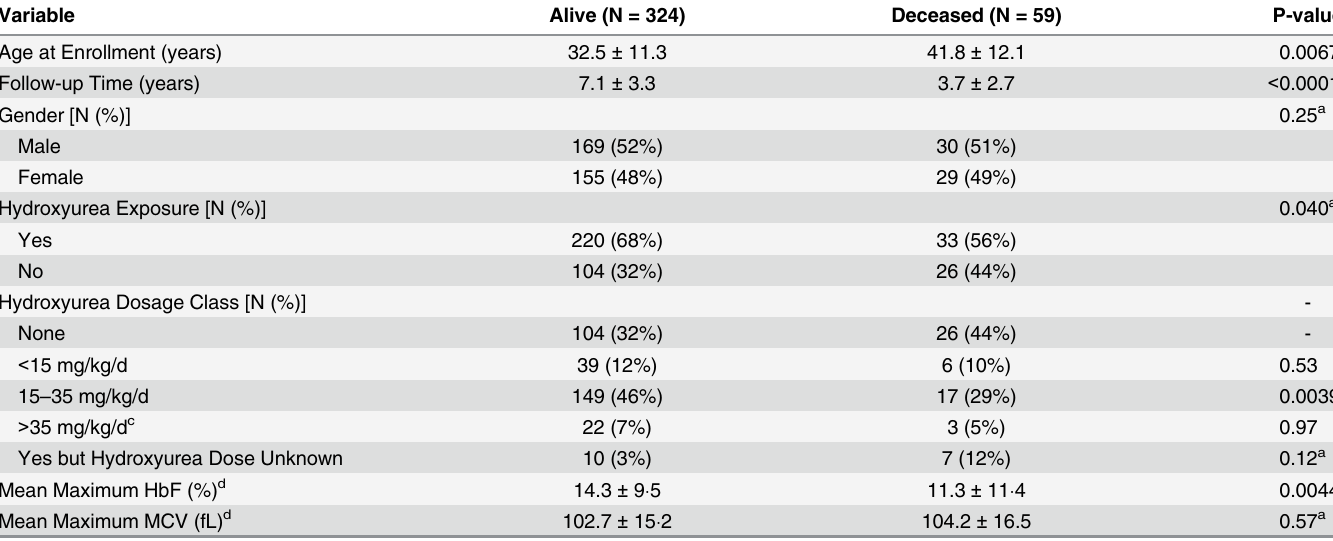
Table 2. Characteristics Regarding Hydroxyurea in Living and Deceased Subjects with